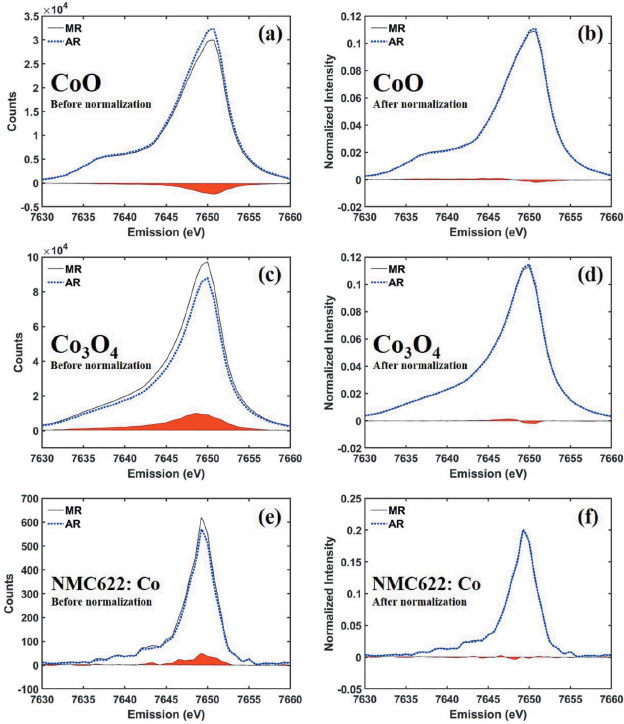
Figure 5 Co K (cid:2) 1,3 spectra of cobalt oxides converted by MR and AR. The solid black line and the dotted blue lines represents MR and AR, respectively, for ( a , b ) CoO before and after normalization, ( c , d ) Co 3 O 4 before and after normalization, and ( e , f ) NMC622 at Co K (cid:2) 1,3 emission spectra before and after normalization, respectively. The red colored areas indicate the differences between the MR and AR spectra.